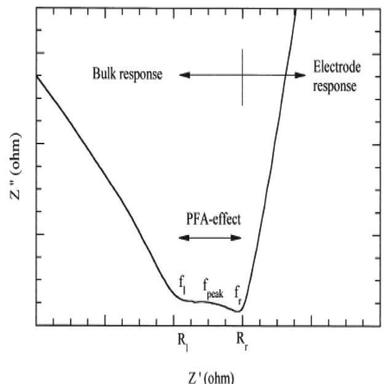
Nyquist plots for low-lime fly-ash systems at early stages.